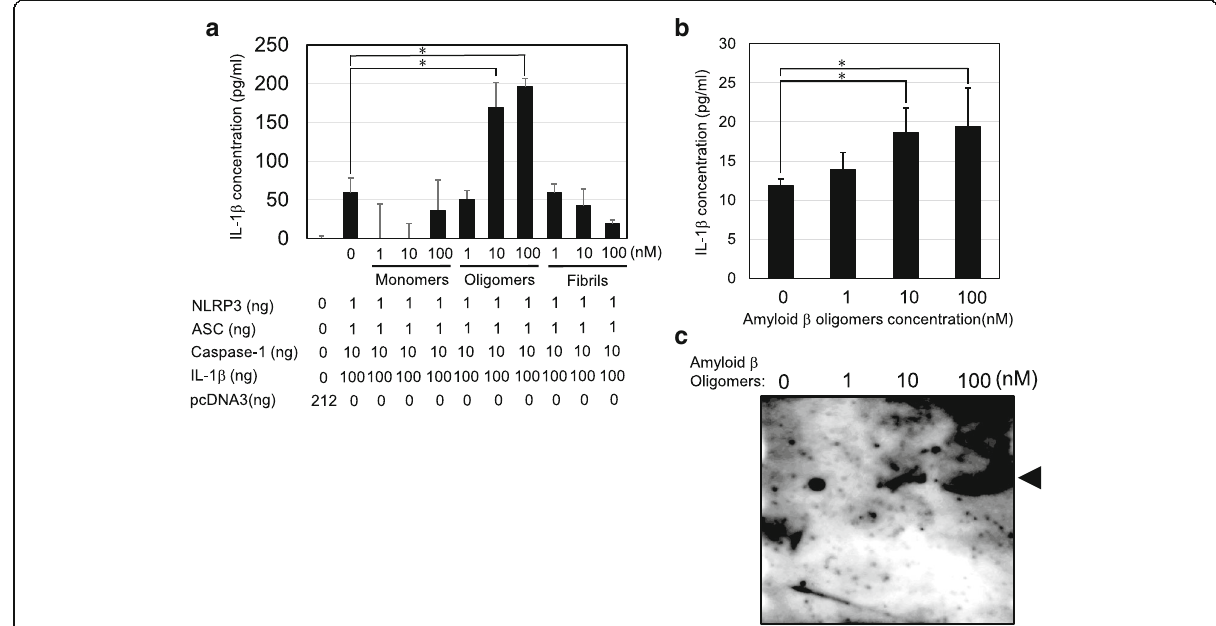
Fig. 3 IL-1 β secretion from living cells. a Cell-based assay using human embryonic kidney (HEK) 293T cells transfected with NLRP3, ASC, caspase-1, and IL-1 β . IL-1 β concentrations were evaluated by ELISA after a 16-h incubation with A β monomers, oligomers, or fibrils. b Cell-based assay using human peripheral mononuclear cells. IL-1 β concentrations were evaluated by ELISA after a 16-h incubation with A β oligomers. c Caspase-1 activation in cell lysates was detected by immunoblotting corresponding to b . Cleaved-caspase-1 is indicated by